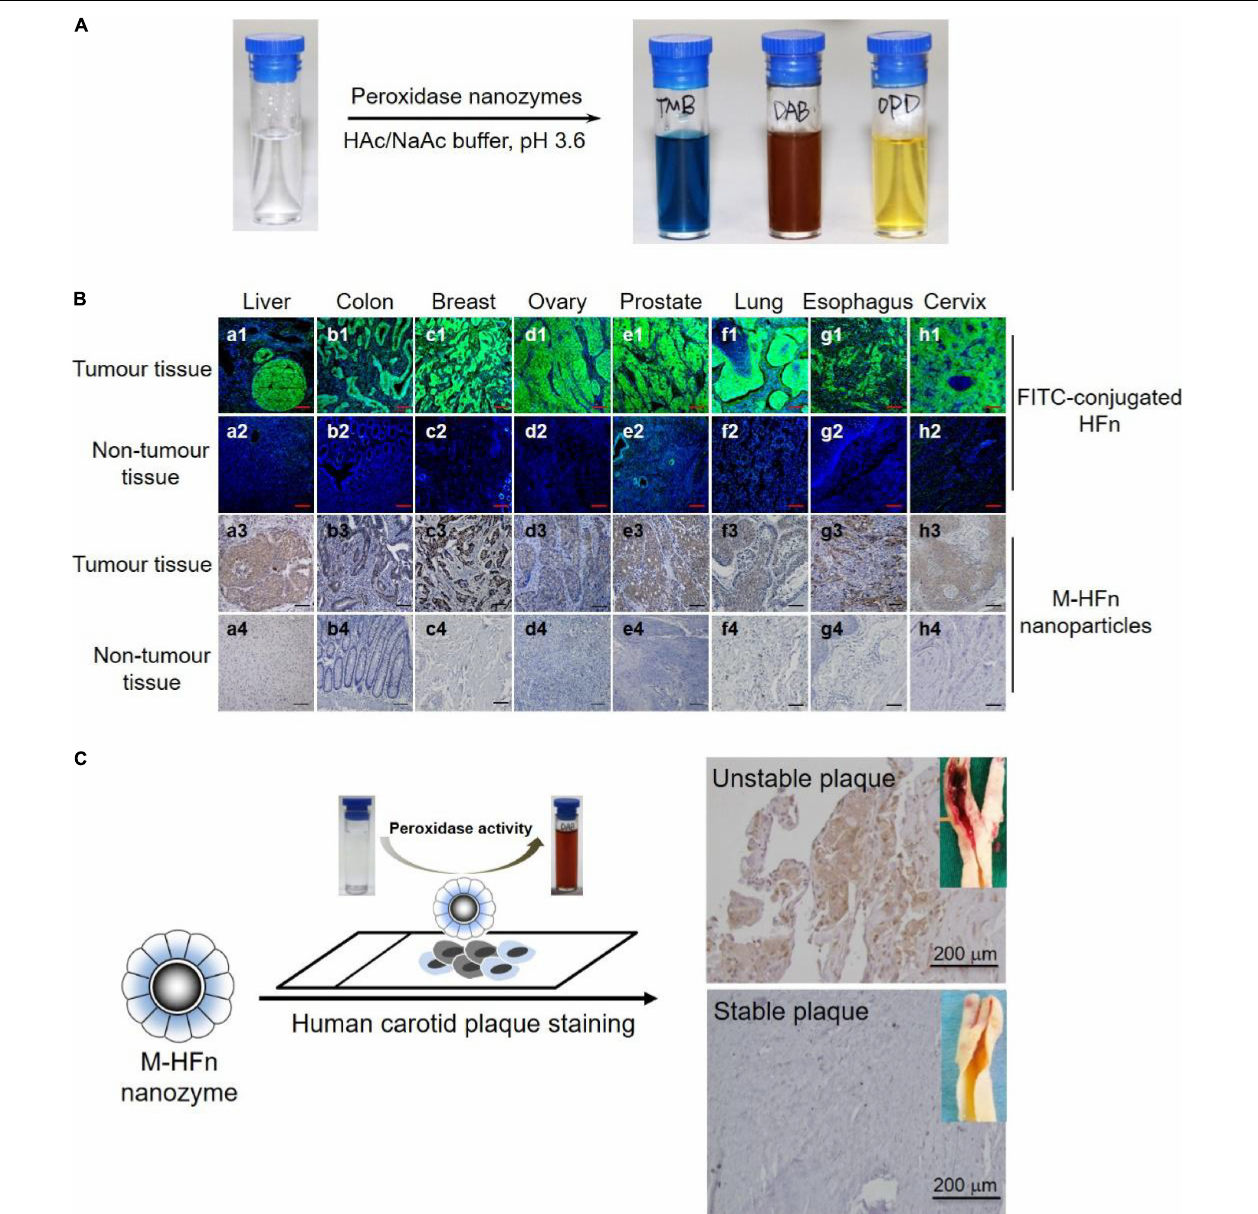
FIGURE 1 | Nanozymes for pathological tissue imaging. (A) Peroxidase nanozymes catalyze the oxidation of various peroxidase substrates (TMB, DAB, and OPD) in the presence of H 2 O 2 to produce different color reactions. Adapted with permission from ref (Jiang B. et al., 2018), © 2018, Springer Nature. (B) M-HFn nanozymes specifically stained tumor tissues from different organs. Adapted with permission from ref (Fan et al., 2012), © 2012, Springer Nature. (C) Peroxidase nanozymes for the pathological identification of unstable atherosclerotic plaques from patients with symptomatic carotid disease. Reproduced with permission from ref (Liang and Yan, 2019), © 2019, American Chemical